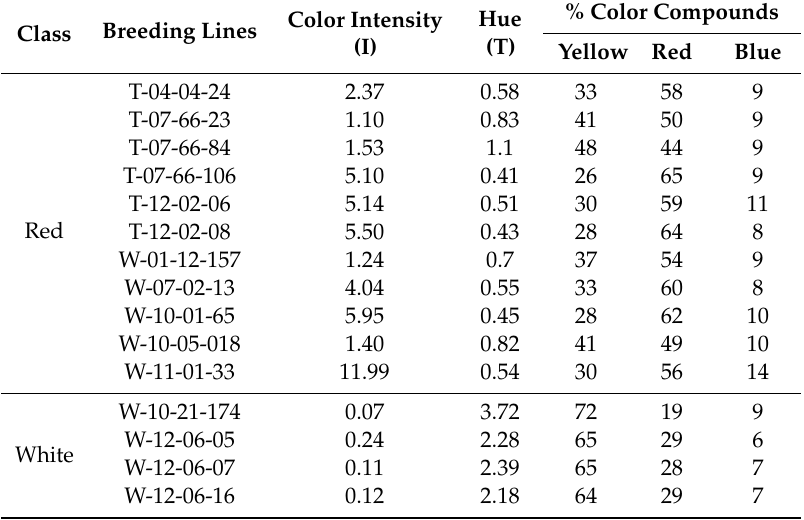
Table 2. Color di ff erences of wines made from di ff erent breeding lines.